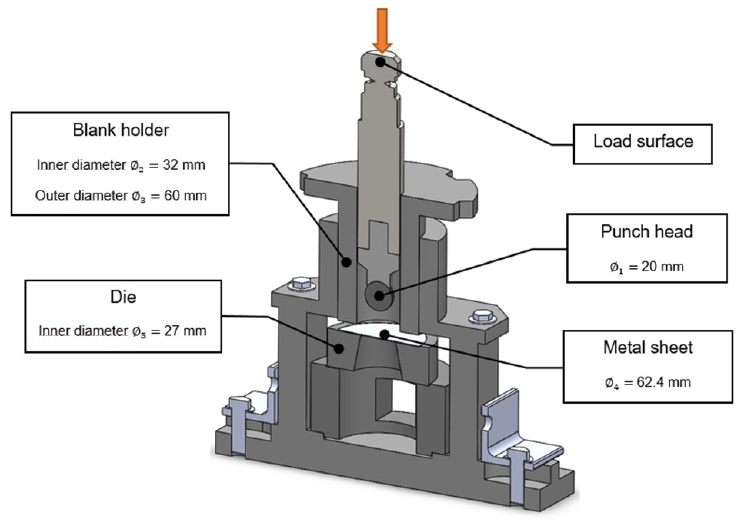
Figure 2. Setup of the Erichsen test: schematic view and geometrical